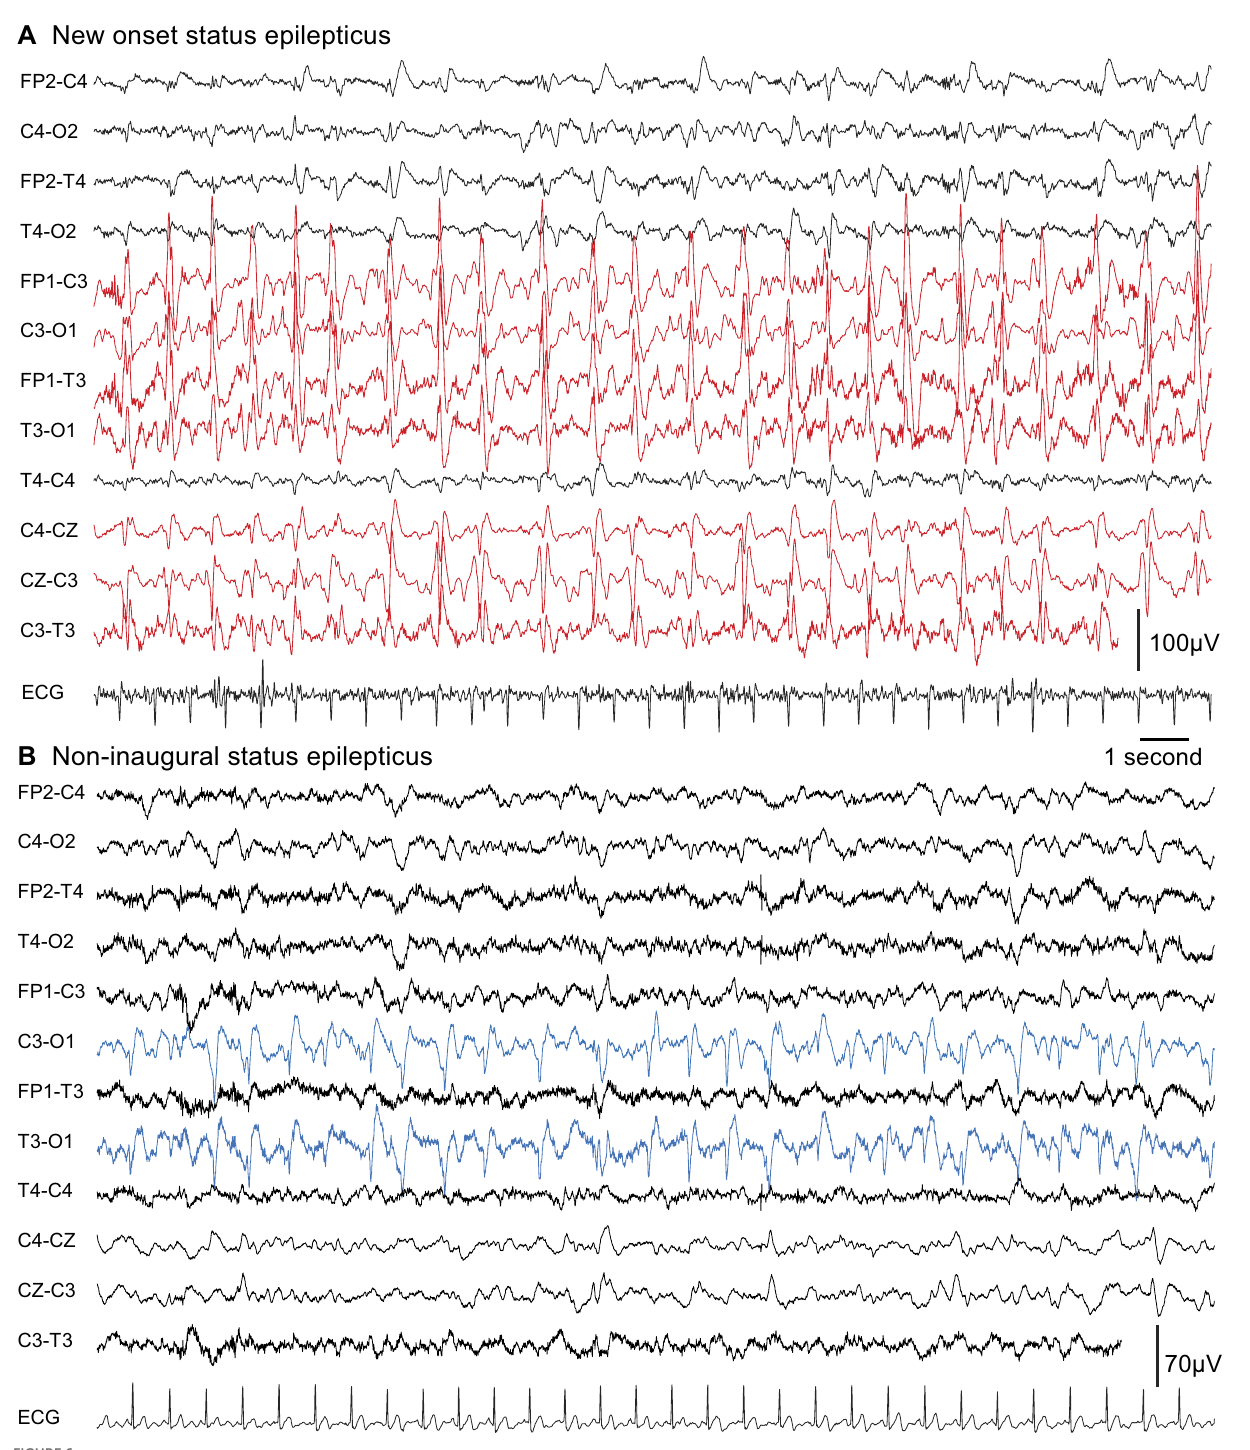
FIGURE6 Two examples of EEG patterns that can be observed in NOSE and NISE. PLDs could be observed in the two types of SE but were more prevalent in NOSE. Here on the left hemisphere. (A) NOSE in a 56-year-old man (chronic psychiatric disorders and alcoholism with decompensated cirrhosis, left cerebral middle artery ischemic sequelae) who presented with a generalized convulsive SE, which became secondarily non-convulsive and super-refractory (SE lasted 41 days until death). PMAs were observed on MRI on the left hemisphere. (B) NISE in a 63-year-old man who presented with refractory non-convulsive SE (SE lasted 8 days). A context of stroke sequelae in the left middle cerebral artery region due to atheroma, alcoholism, and urinary tract infection. PMA was observed on MRI. After an initial stay of 54 days, there was an SE recurrence in 80 days leading to death in 4